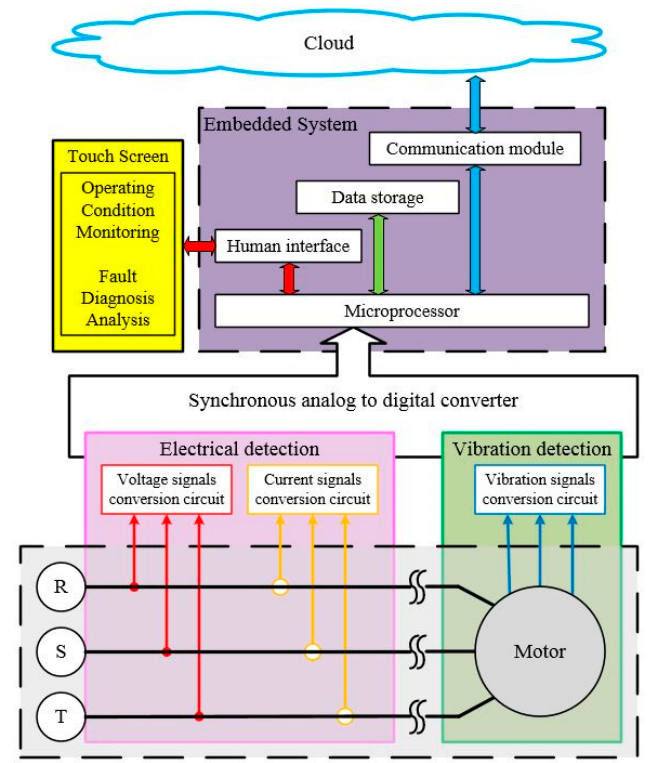
Figure 1. Overall system